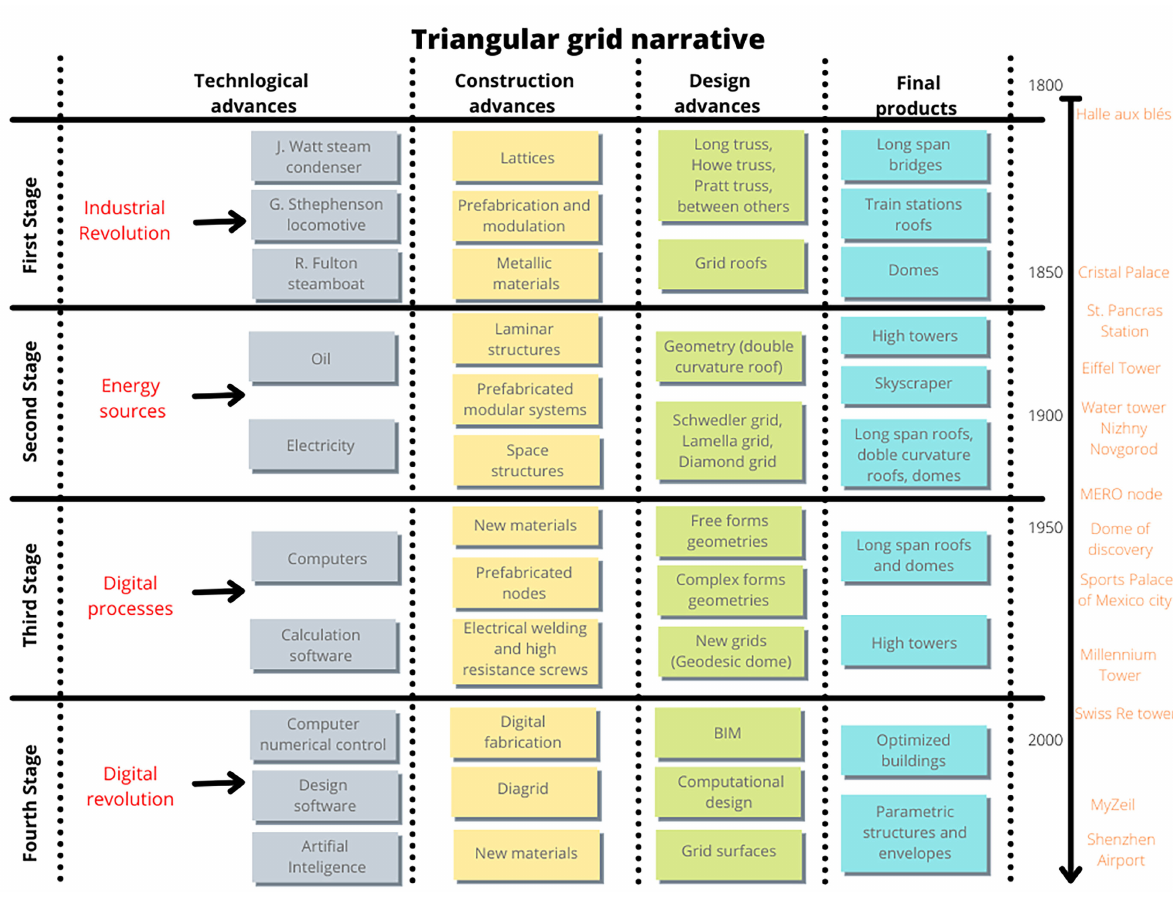
Figure 11: 3D model of the structure of the Sports Palace of Mexico City using parametric